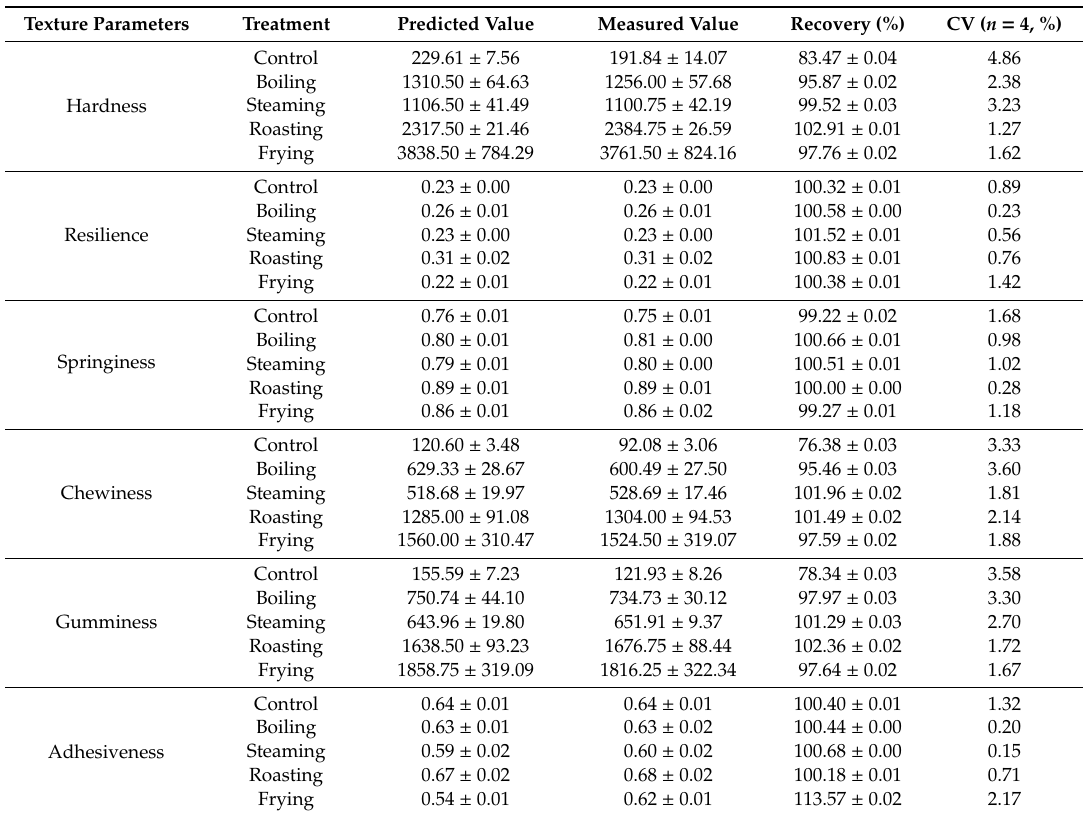
Table 5. PLS regression model results for predicting texture parameters with the CPMG relaxation data of Spanish mackerel subjected to di ff erent cooking